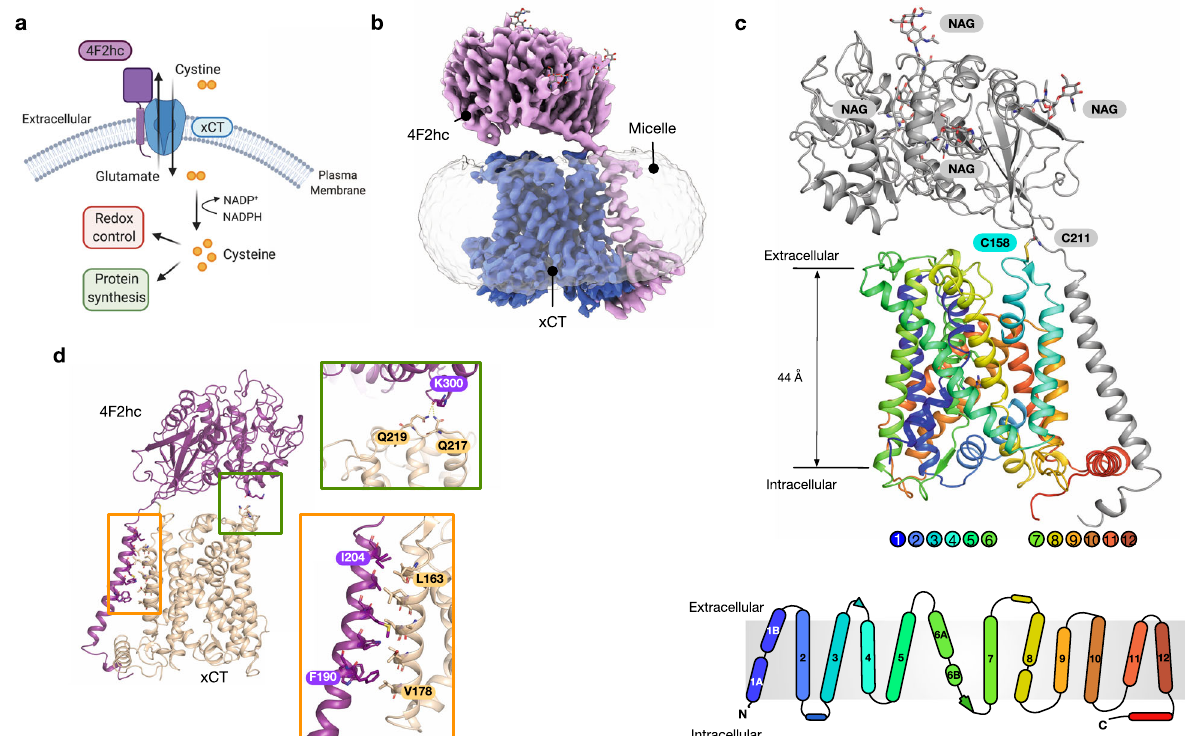
Fig. 1 Cryo-EM structure of system xc − . a System xc − consists of a heavy chain component, 4F2hc (SLC3A2) and a transport module, xCT (SLC7A11), and functions as a dedicated cystine import system, exchanging extracellular L -cystine for intracellular L -glutamate. Following L -cystine transport into the cell, the molecule is rapidly reduced to L -cysteine via cystine reductase and used to regulate cellular redox levels via glutathione, alternatively free cysteine can also enter the protein synthesis pathway. b Cryo-EM density of 4F2hc (magenta) and xCT (blue) contoured at a threshold level of 1.0, superposed with lower-contoured threshold level of 0.22 to display the detergent micelle (grey). c Cartoon representation of system xc − , with 4F2hc (grey) showing conserved N-linked glycans (NAG). xCT is coloured blue from the N-termini to red at the C-terminus. The cysteines forming the disulphide which connects the two components are also indicated. A topology diagram is also shown of SLC7A11, using the same colours as in the main panel. d Analysis of the interactions between 4F2hc and xCT. The zoomed in views show the interactions between the extracellular domain (green box) and transmembrane domains (orange